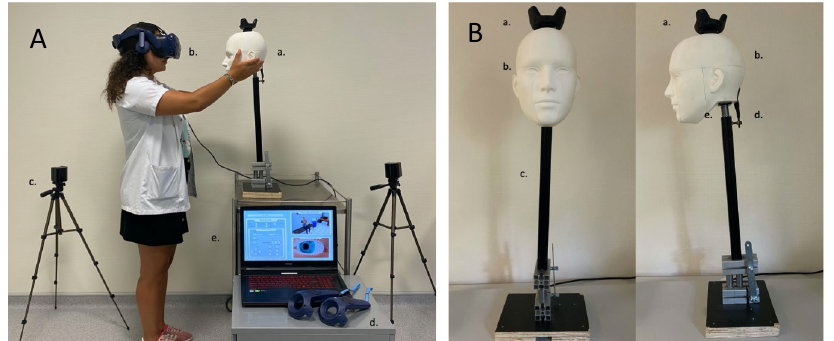
Figure 4. The simulation system. ( A ) The system (A) is composed of an articulated mannequin (a), a virtual reality headset (b), tracking cameras (c) to detect the mannequin and the trainee position, controllers (d) for calibration and examination purposes (not used in this study), and the laptop PC (e), providing the control interface to the trainer. ( B ) A tracker (a) is fixed on a 3D-printed human head (b) corresponding to the avatar seen in the virtual office. A rigid rod (c) articulated at its base for Dix–Hallpike maneuvers (not tested in this study) and supports the head by a spring (e) and 2 rubber bands (d) providing the haptic feedback for the passive head